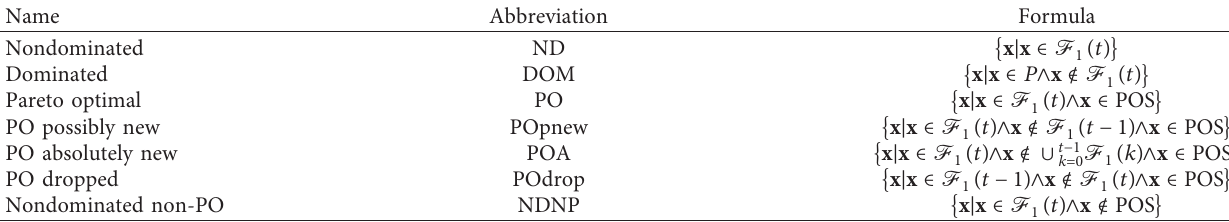
Table 1: Generational search-assessment